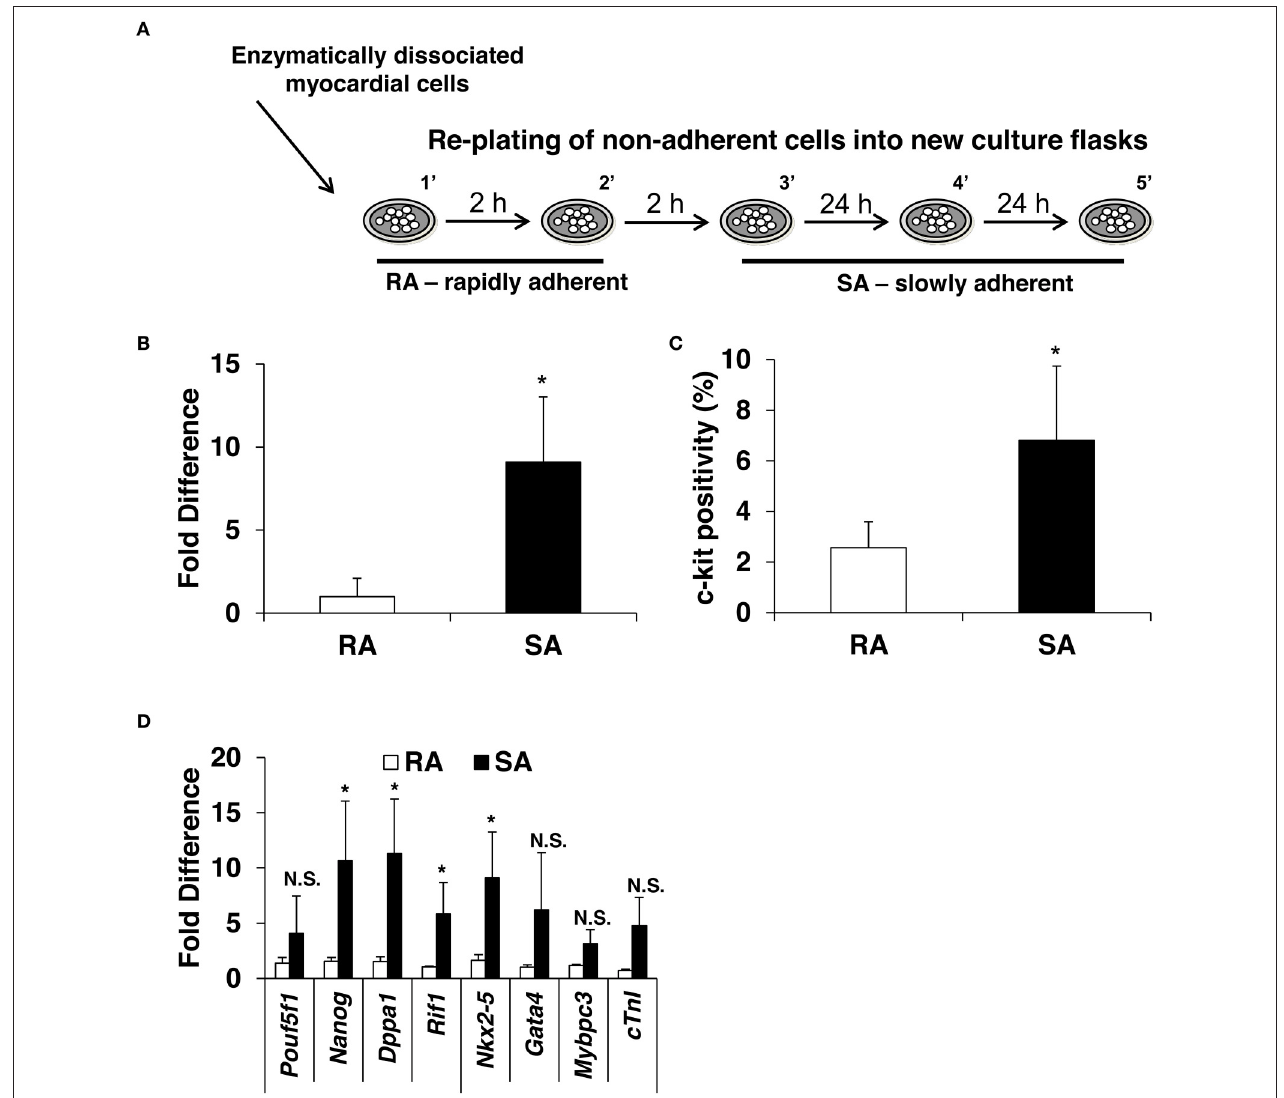
FIGURE 2 | Expression of c-kit, pluripotency and cardiac markers in CMCs isolated from RA and SA fractions. Schematics of CMCs RA and SA isolation (A) expression of c-kit in CMCs from RA and SA fractions 4–6 days after isolation and expansion at mRNA level by qPCR ( n = 4) (B) and protein level by flow cytometry ( n = 4) (C) . Real-time PCR on cells from RA and SA cells without sorting ( n = 3) (D) . Values are mean ± SD * p < 0.05 vs. SA.